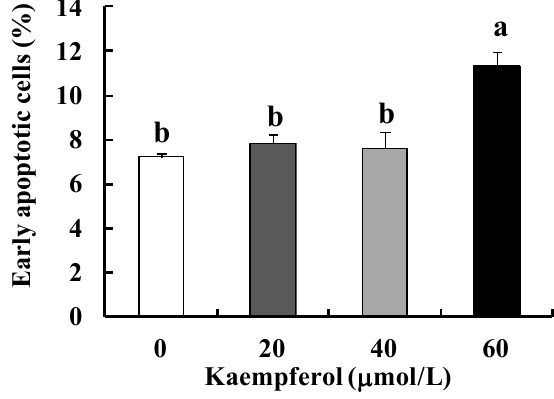
Figure 3. Effect of kaempferol on apoptosis of SW480 cells. Cells were plated in 24-well plates and treated with various concentrations of kaempferol for 48 h. Cells were trypsinized, loaded with Annexin V and 7-AAD, and analyzed by flow cytometry. The percentages of early apoptotic cells were calculated. Each bar represents the mean ± SEM ( n = 3). Means without the same letter (a or b) are significantly different ( p <